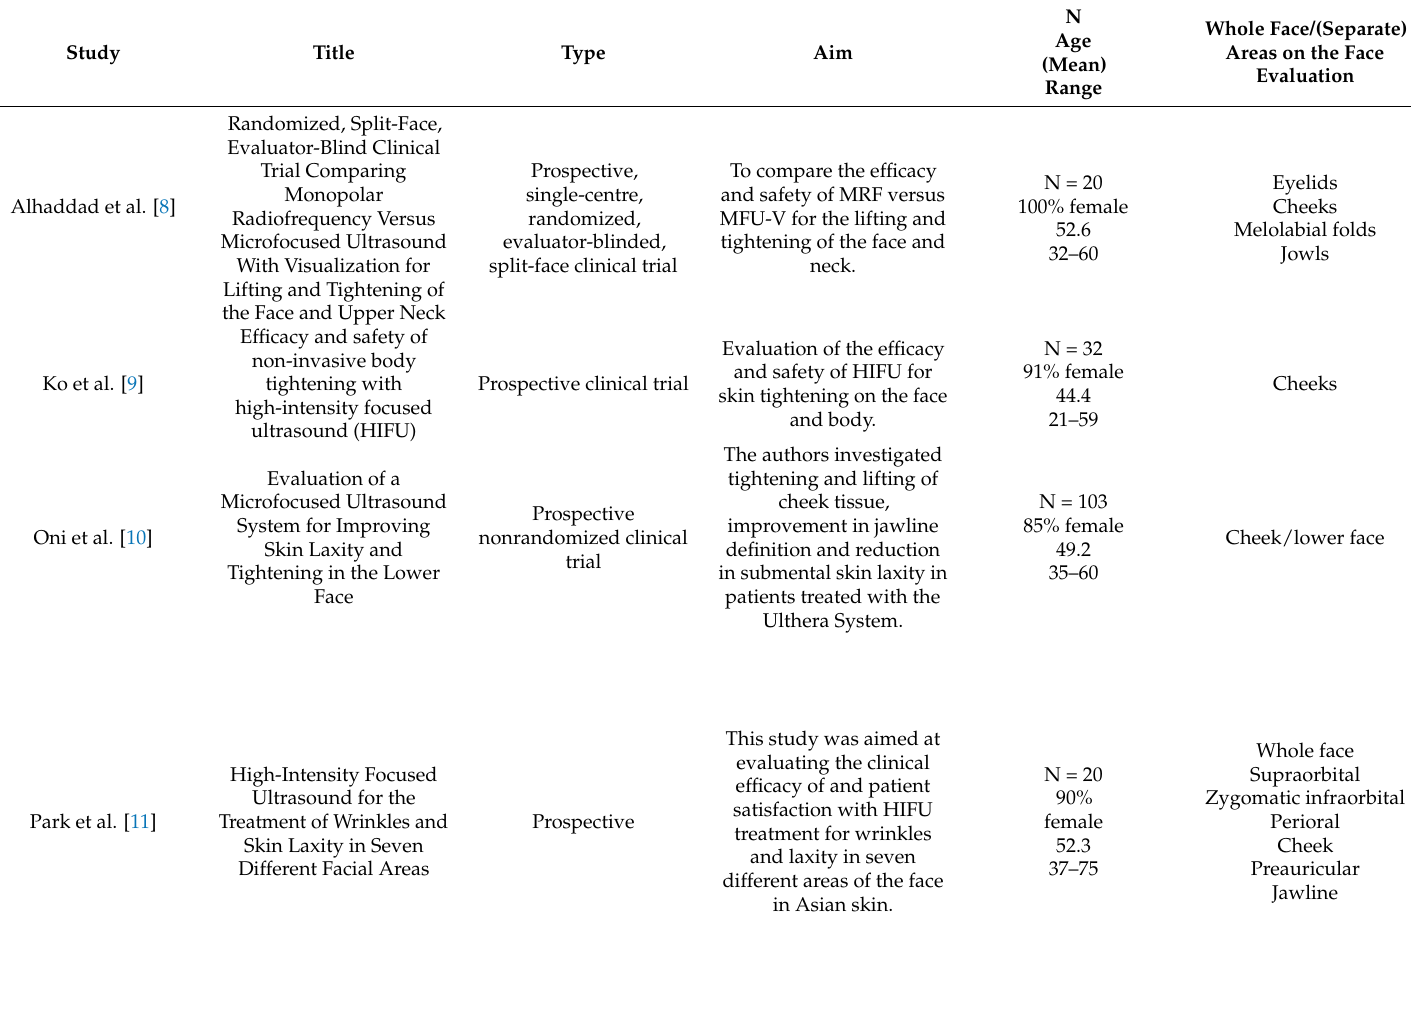
Table 1. Overview of studies